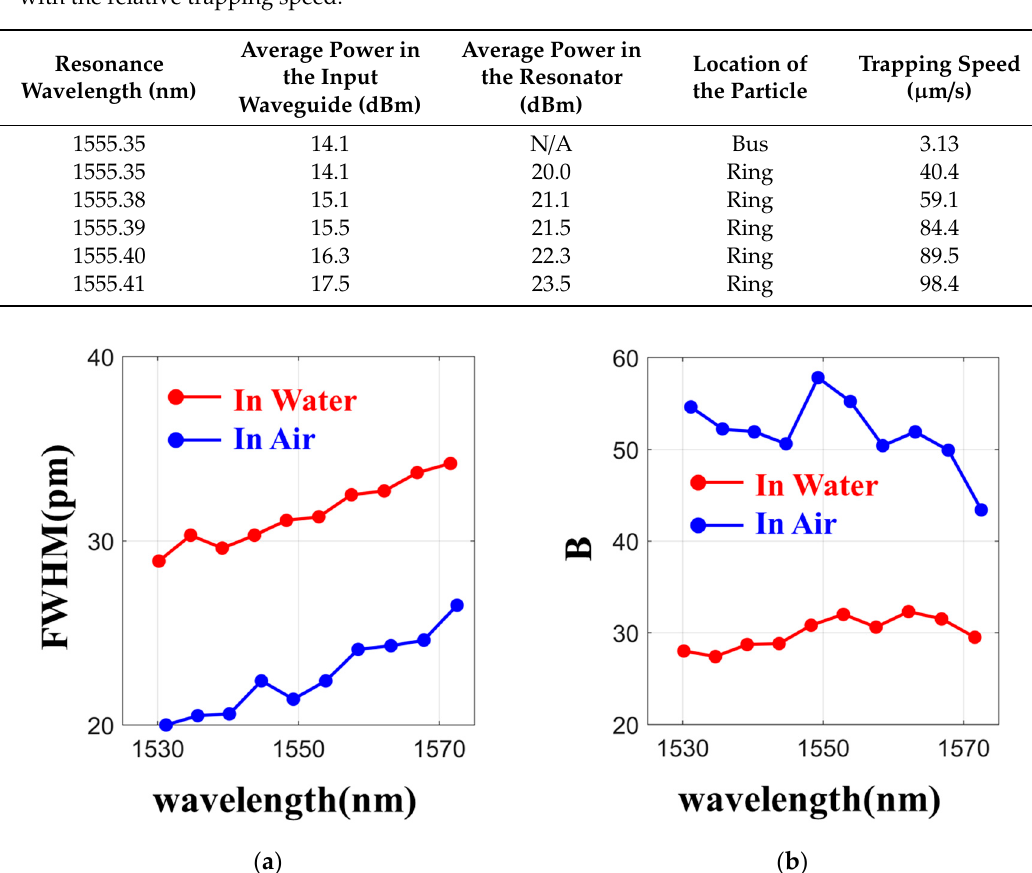
Table 1. The resonance wavelength and estimated average power in the waveguide and the resonator with the relative trapping speed.